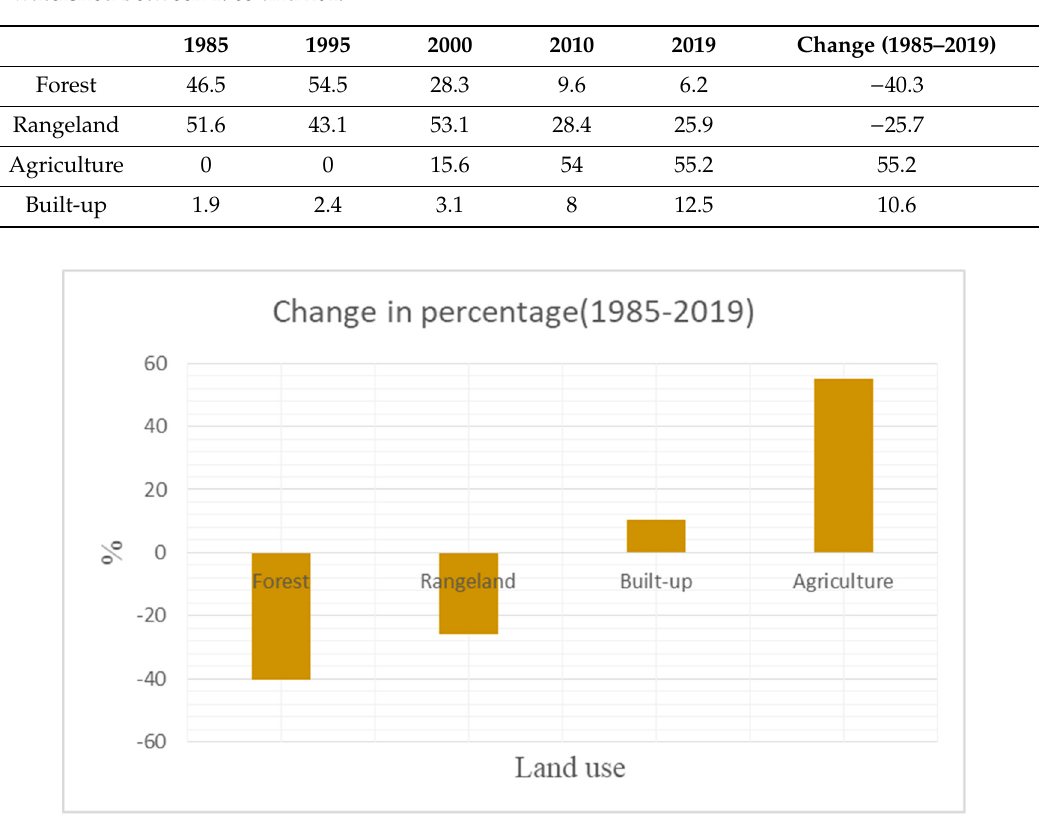
Figure 5. Percent land use / cover change (1985–2019) of Kakia and Esamburmbur sub-catchments of Enkale Narok watershed.